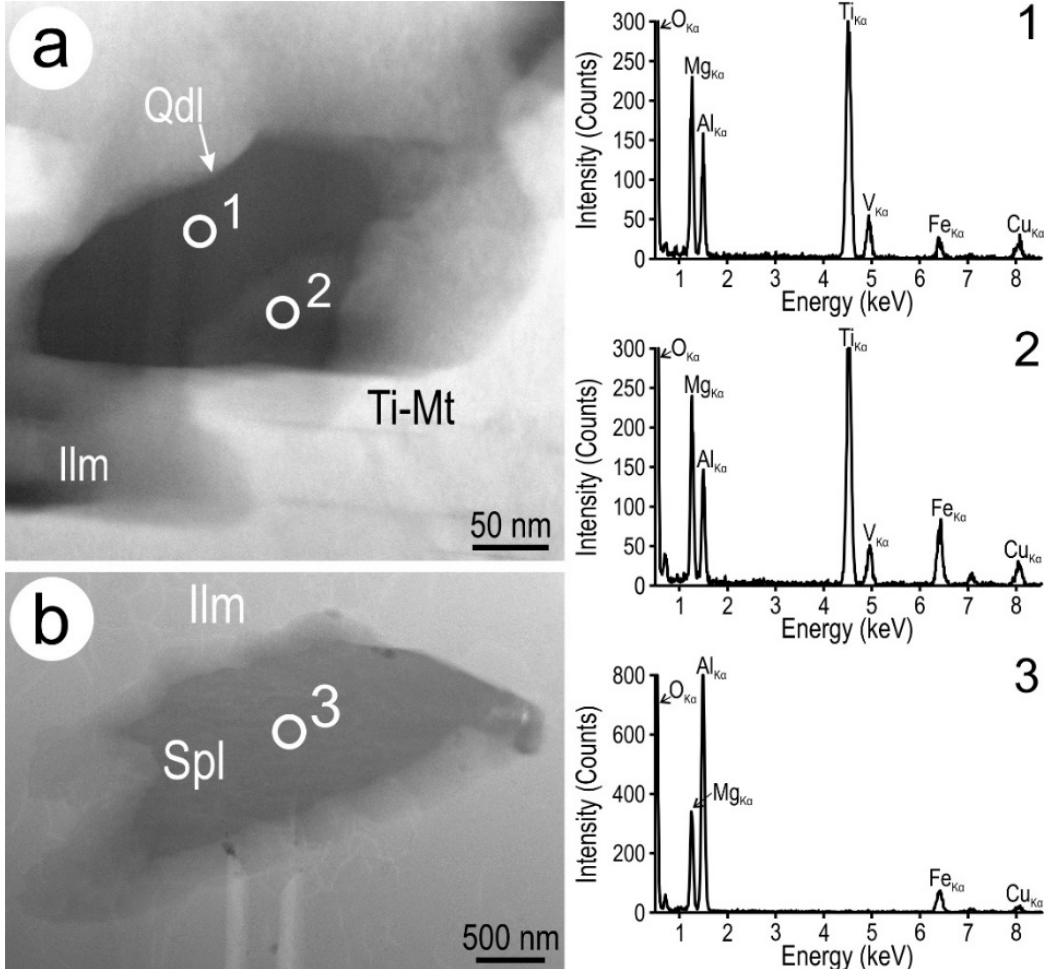
Figure 8. HAADF STEM images (left) and STEM EDS spectra 1–3 (right) showing spinel minerals representative of the association. ( a ) Qandilite (Qdl) with compositional zoning with respect to Fe is dominant throughout the titanomagnetite (Ti-Mt). ( b ) Compositions recognized as spinel sensu stricto (Spl) are representative of the inclusions in ilmenite (Ilm) outside the titanomagnetite. Additional spectra are shown in Supplementary Materials Figure S5. The Cu signal is from the TEM grid.